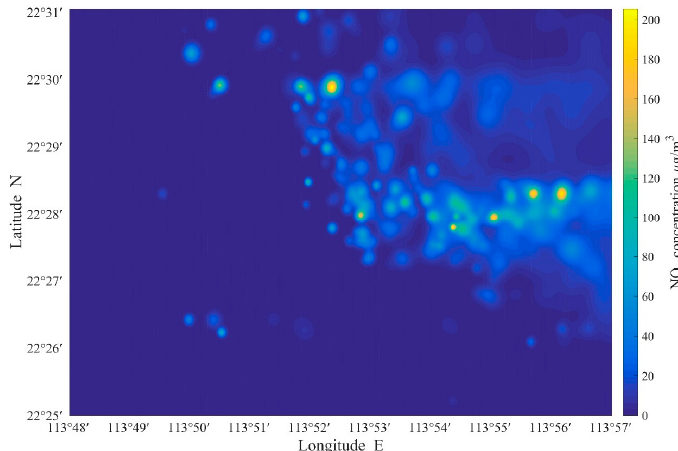
Figure 7. NO 2 concentration distribution at 2:00.